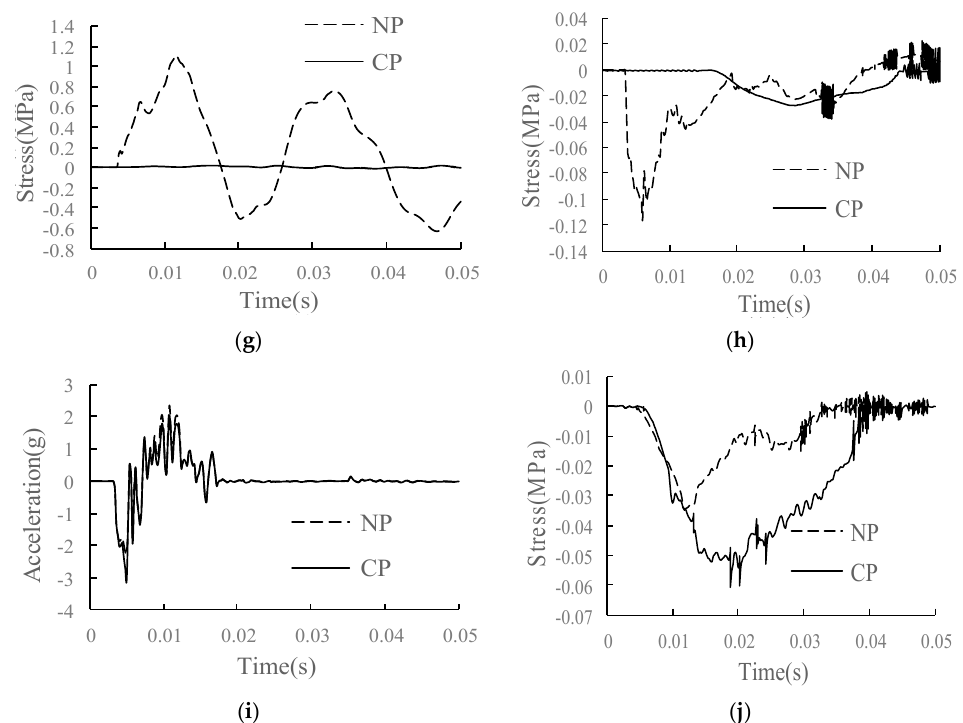
Figure 25. Dynamic response diagram of each structural layer in the condition of CP: ( a ) wheel–rail vertical force; ( b ) rail acceleration; ( c ) rail vertical speed; ( d ) rail vertical displacement; ( e ) track slab acceleration; ( f ) acceleration of SCC layer; ( g ) longitudinal stress of SCC layer; ( h ) vertical stress of SCC layer; ( i ) base acceleration; ( j ) vertical stress of substructure.